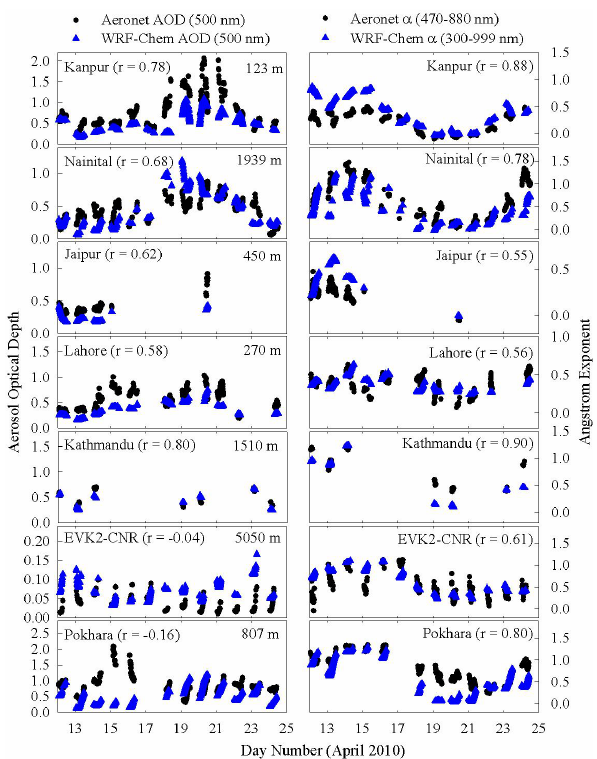
Fig. 8. Variations in co-located AERONET observed and WRF- Chem simulated aerosol optical depth at 550nm (left panels) and Ångström exponent (right panels) at seven sites located in the model domain during 13–25 April 2010. The correlation coefficients ( r ) are also shown for both the parameters at all the seven sites and numbers in the upper right corner of left panels represent the alti- tude of